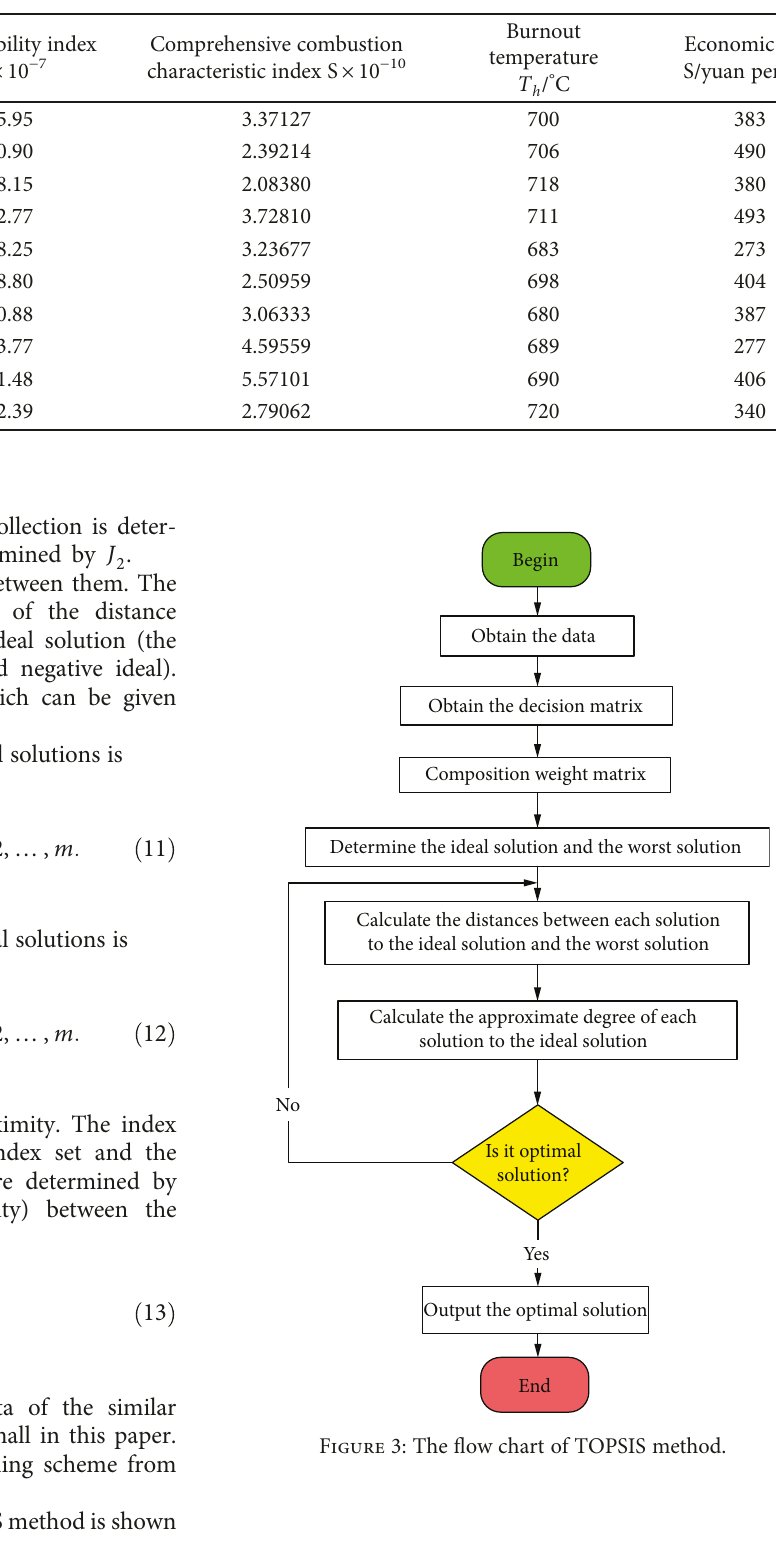
Table 3: Performance index of mixed coals with di ff erent proportions.